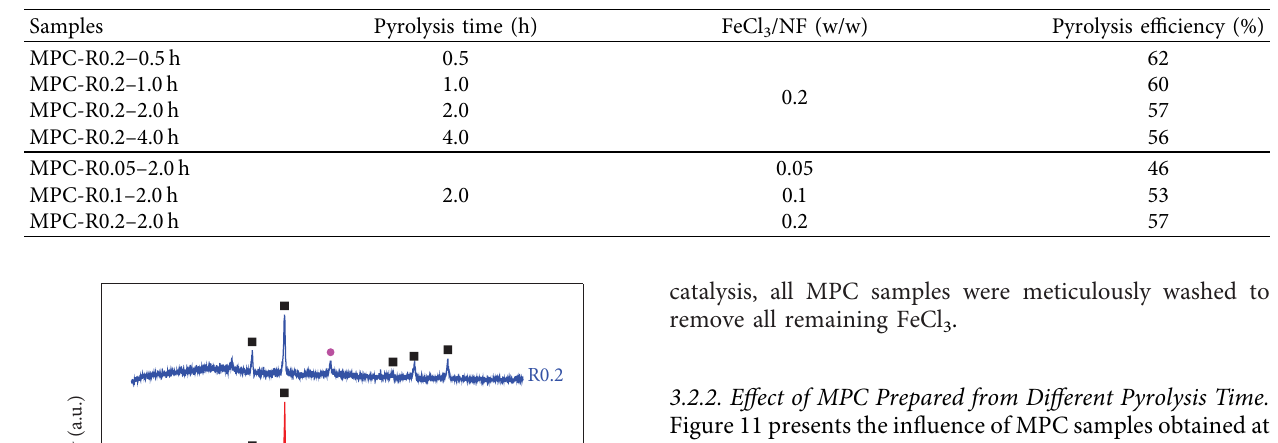
3 -loaded nipa frond.